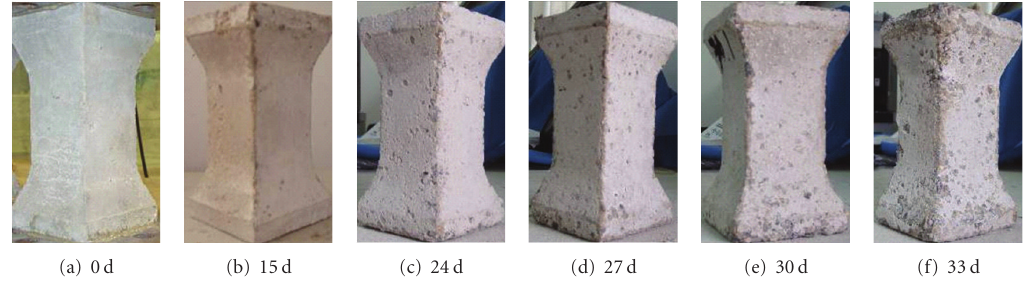
Figure 6: Surface description of the concrete specimens corroded for di ff erent period.